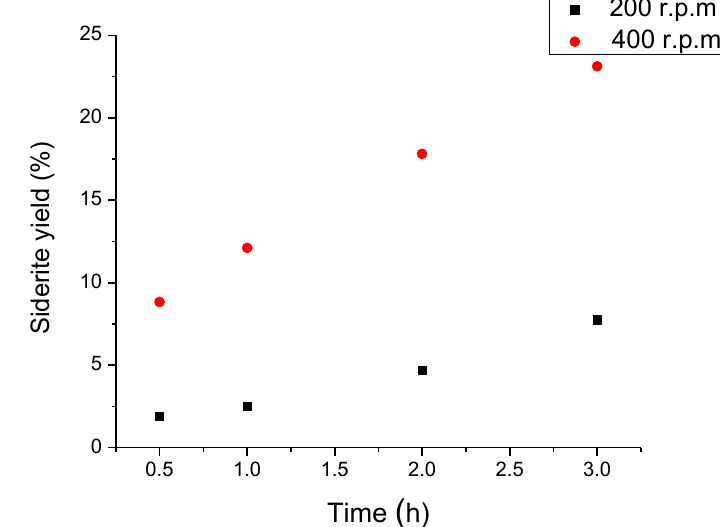
Figure 9. Siderite formation as a function of rotation speed at 20 bar CO 2 pressure and 32 °C in the ball milling process.